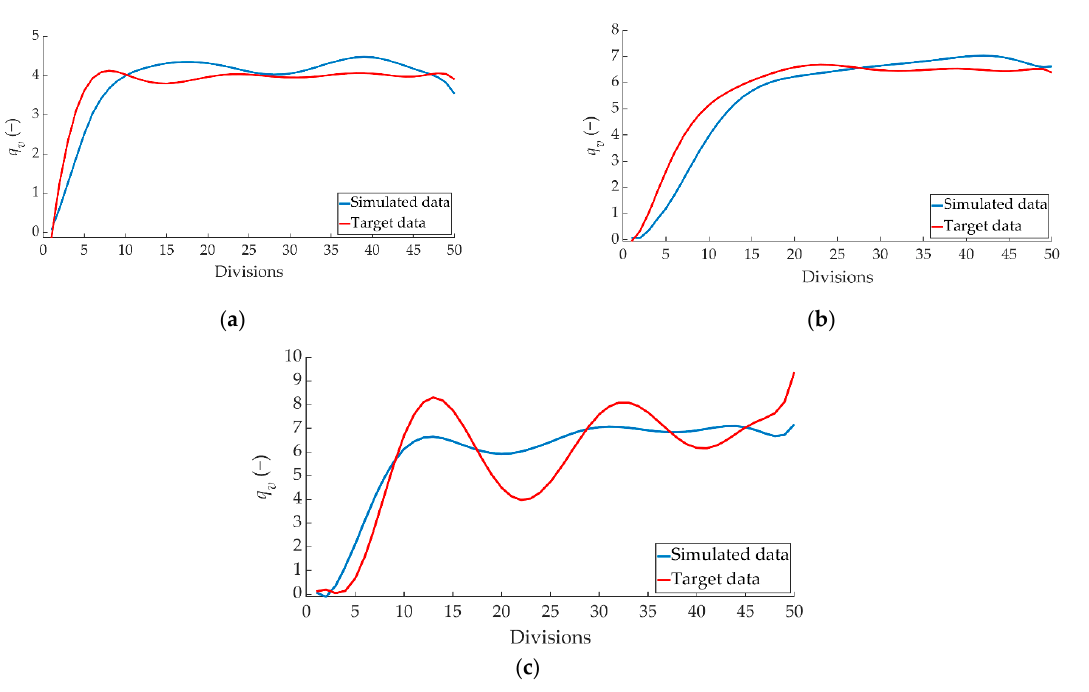
Figure 19. Comparison between the ANN-simulated data and target q v data for the left pressure sensor for braking at a speed of 70 km/h for the type: ( a ) maintained, ( b ) progressive and ( c ) emer- gency. Figure 20 shows the comparison between the ANN-estimated values and the target data for vfill t .